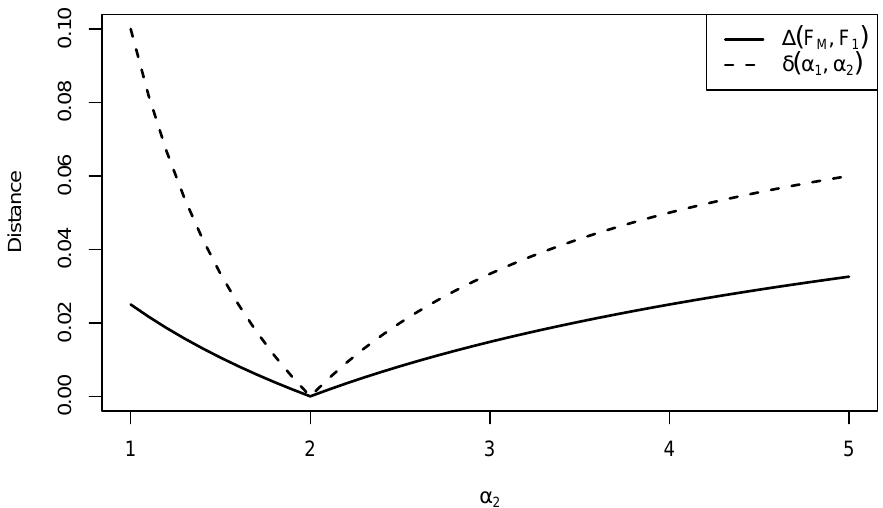
Figure 1. The distance ∆ ( F M , F 1 ) with mixing parameter p = 0.9 and an upper bound δ ( α 1 , α 2 ) vs. parameter α 2